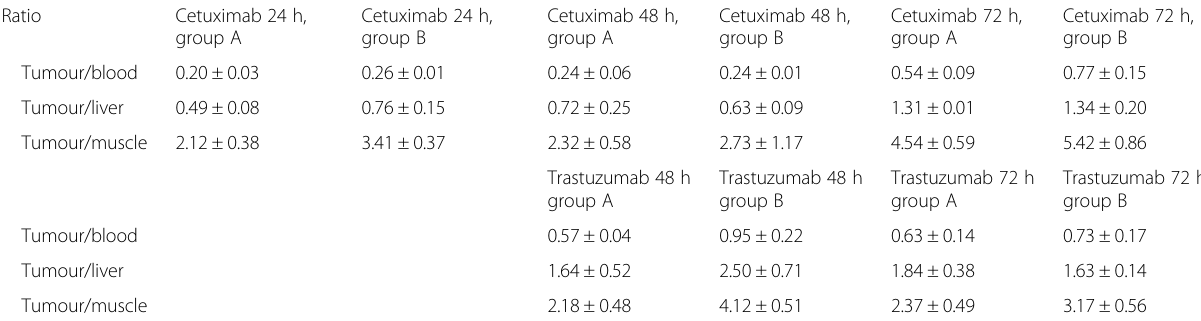
Table 1 Tumour-to-tissue ratios for pretargeted cetuximab and trastuzumab at 4 h after the injection of [ 18 F]TAF